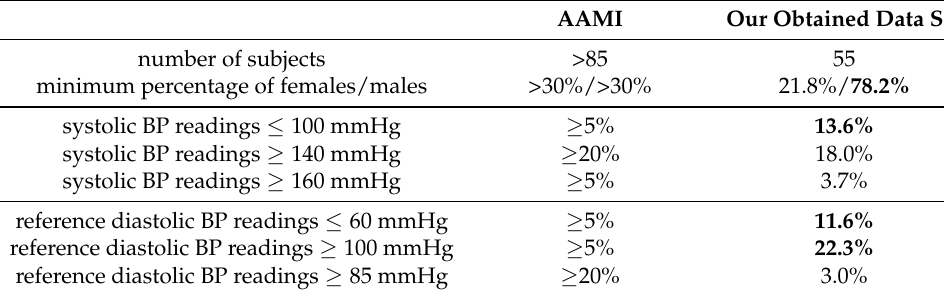
Table 3. Data requirements in AAMI standard [50].